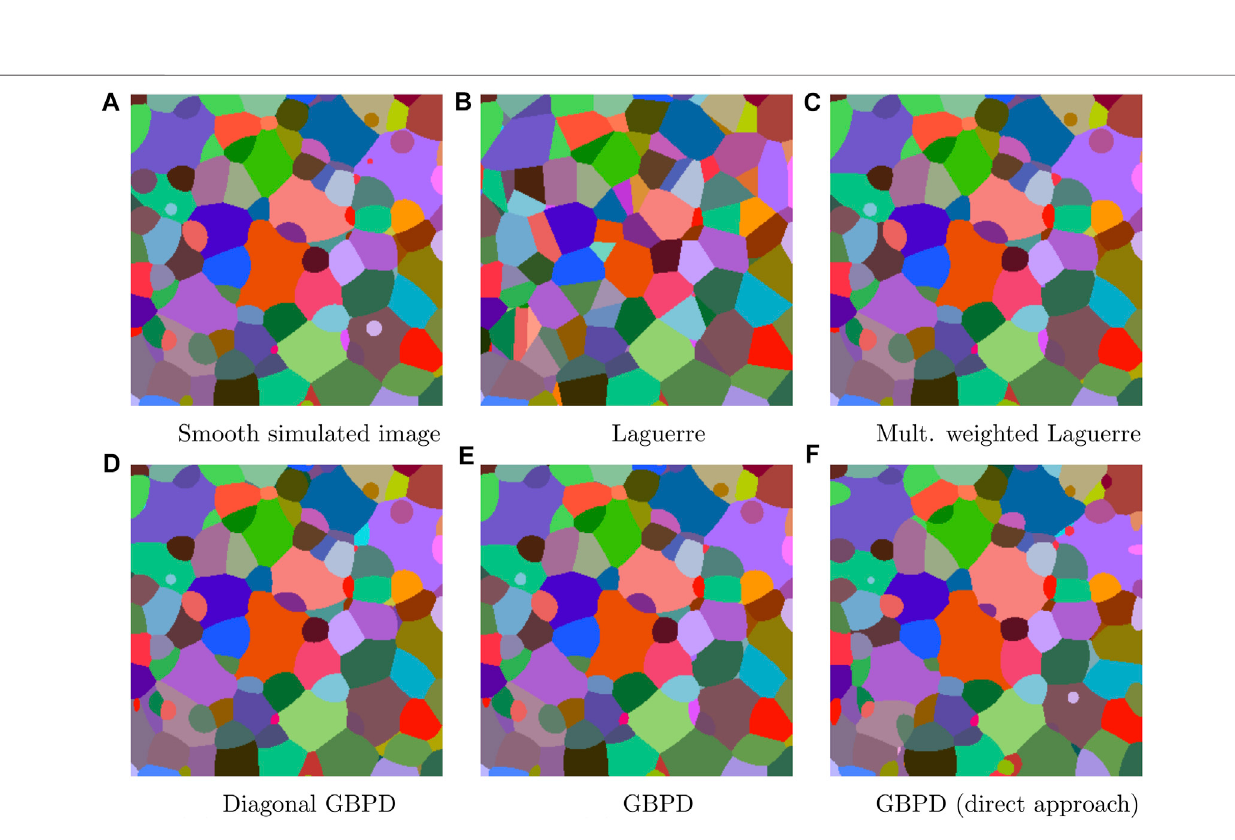
FIGURE8| Two-dimensionalslicesthrough (A) thesmoothsimulatedimage I sim and (B) – (F) tessellations fi ttedtotheperturbed simulatedimagedata I pert with σ (cid:1) 1. The fi ts in (B) – (E) were obtained by the gradient descent-based method described in Section 2.3 , whereas ( F ) followed from the direct approach described in Section 2.4.2